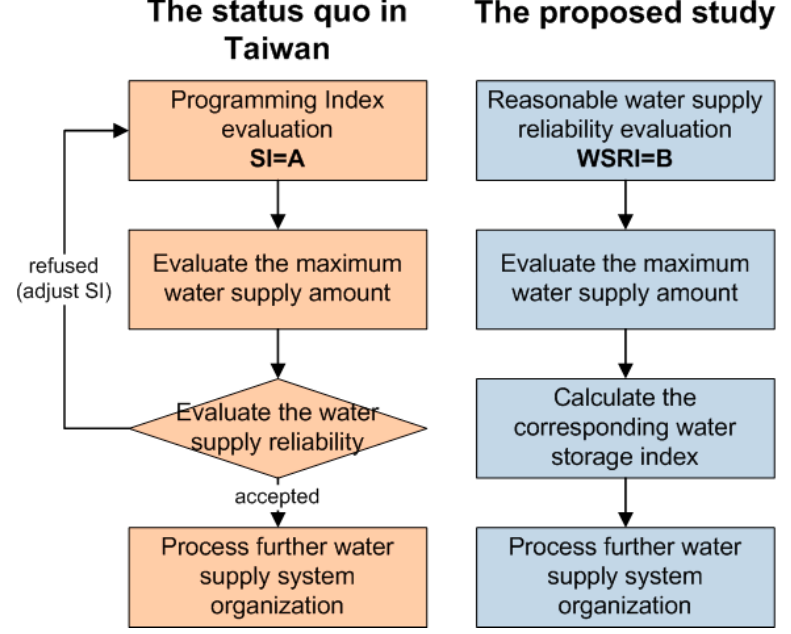
Figure 2. Illustration of different considerations between the status quo and this study.